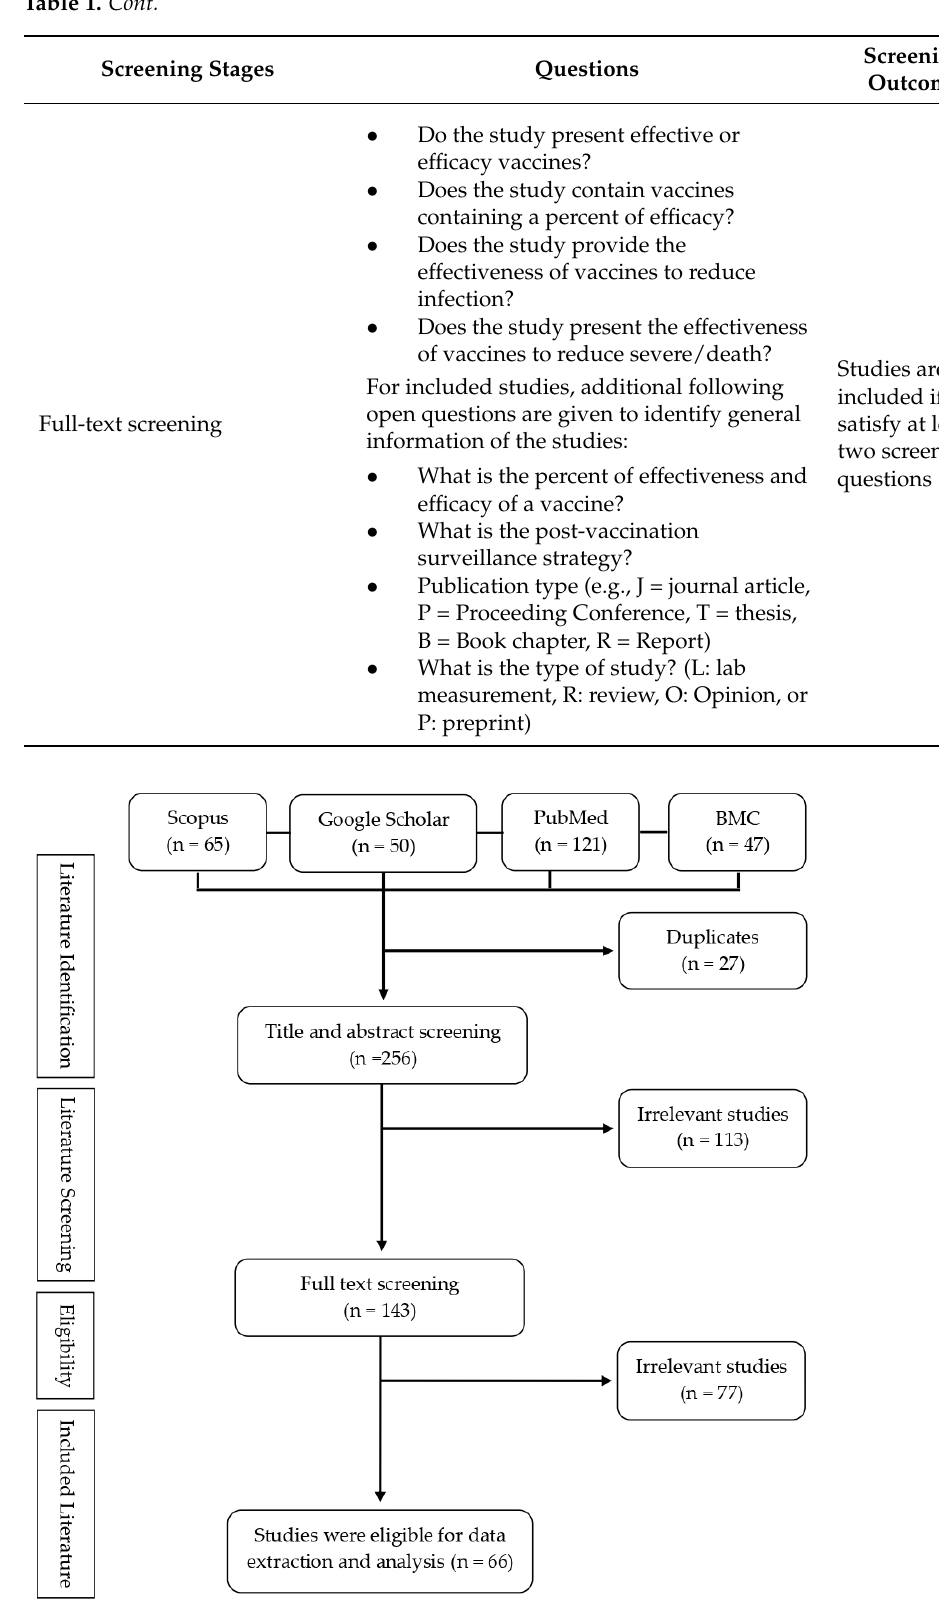
Figure 1. The PRISMA flow diagram depicts the process of selecting eligible studies.